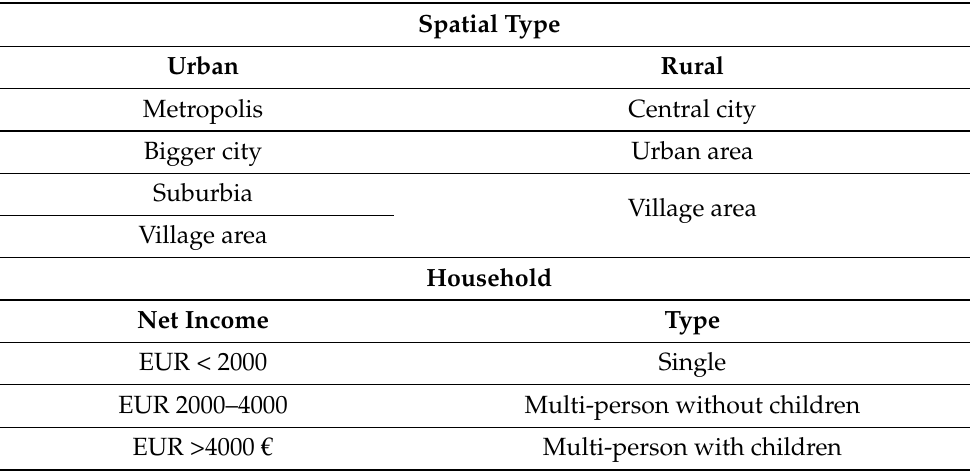
Table 2. Categories for mobility groups (All combinations are